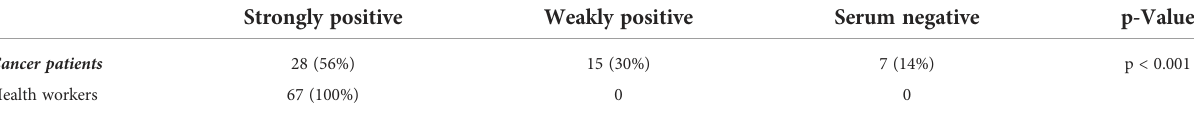
TABLE 5 SARS-CoV-2 neutralizing antibody titers among cancer patients and healthy workers. Strongly positive Weakly